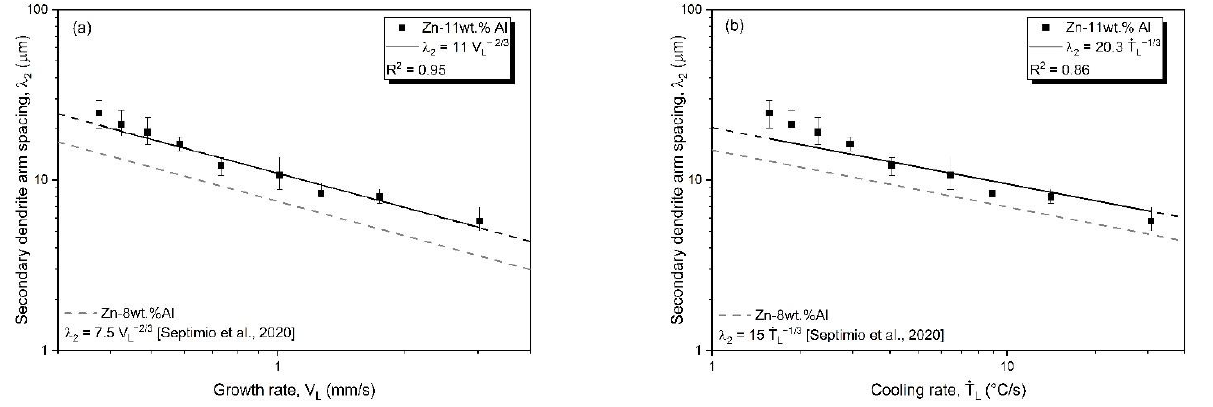
Figure 17. Secondary dendritic arm spacing as a function of solidification thermal parameters for the Zn-11wt.%Al alloy: ( a ) growth rate and ( b ) cooling rate.